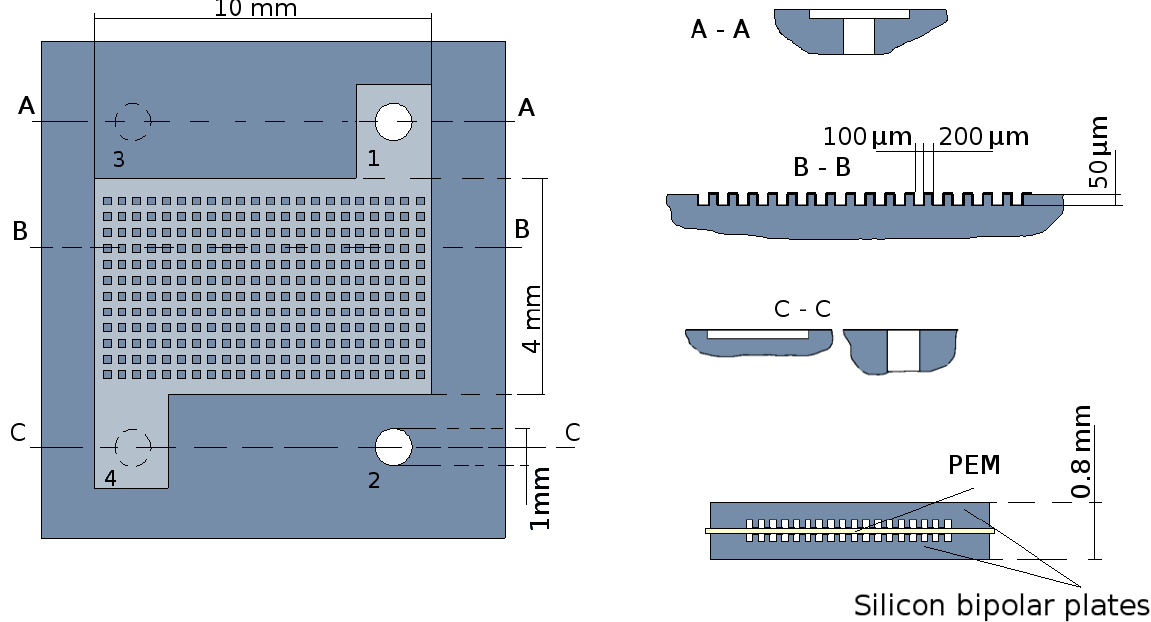
4) gas flow silicon bipolar plate and assembly of a single cell.